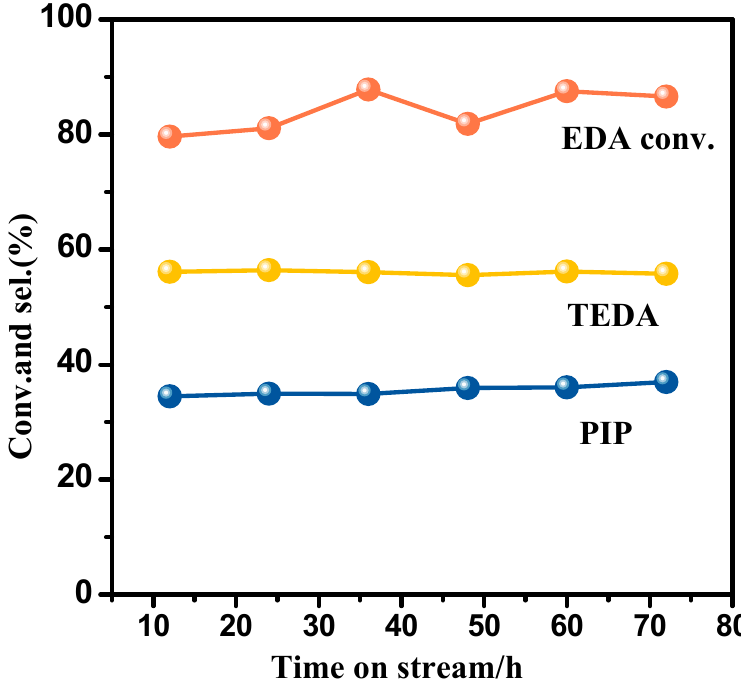
Figure 11. Reaction stability of Sn-containing defective S-1 zeolite catalyst Sn6-S-1 (6 wt.% Sn loading) in the intermolecular condensation of EDA to PIP and TEDA (for reaction conditions, see Figure 9).